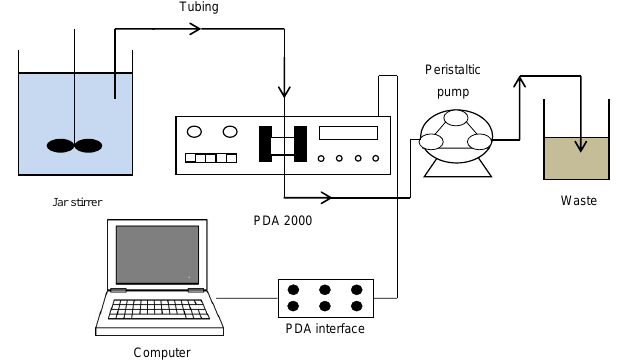
Figure 1. Experimental set